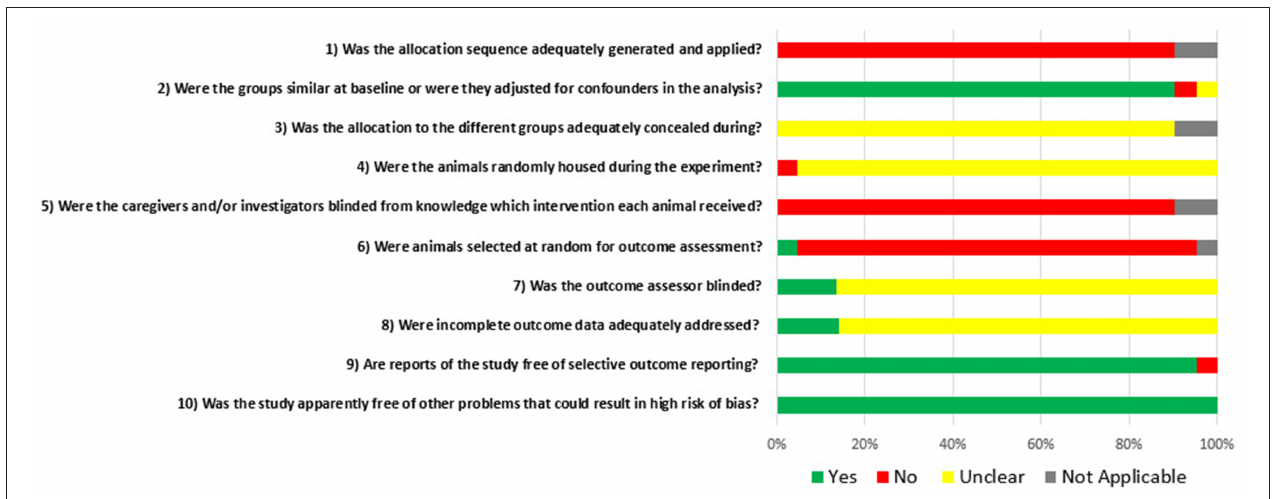
FIGURE 5 | Risk of bias, averaged per each signal question. Yes = low risk of bias; No = high risk of bias; Unclear = unclear risk of bias; and Not